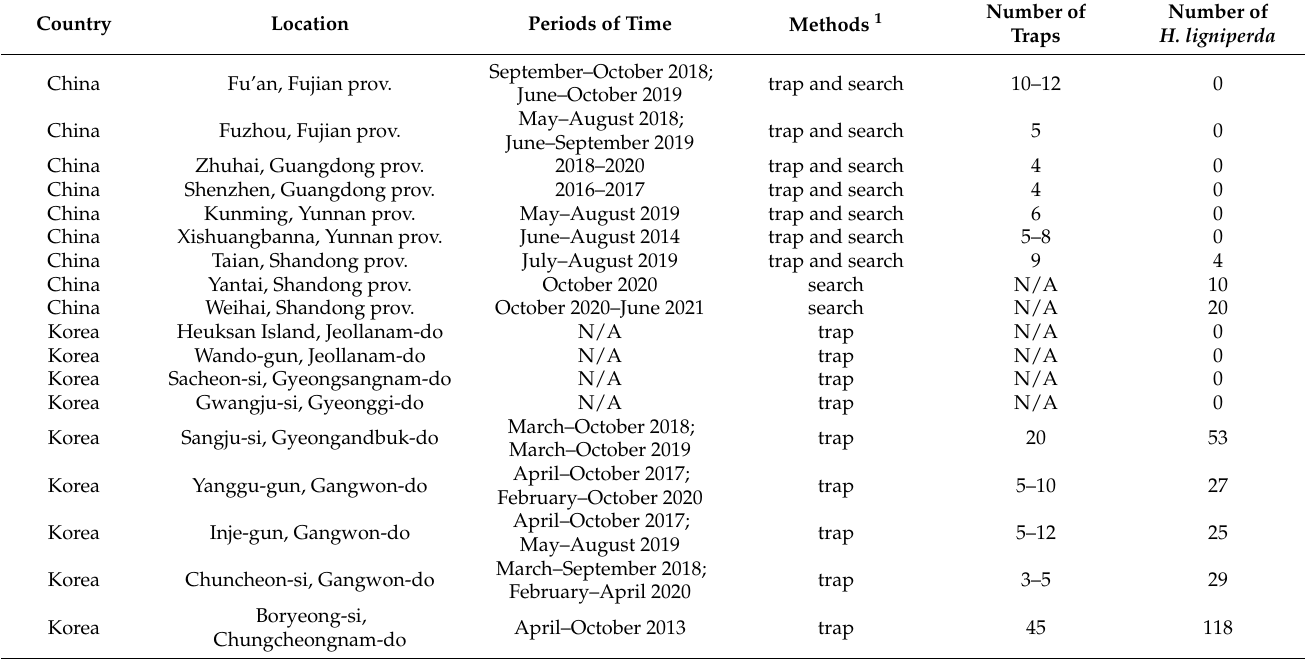
Table 1. Survey of Hylurgus ligniperda in China and Korea in this study. Periods of